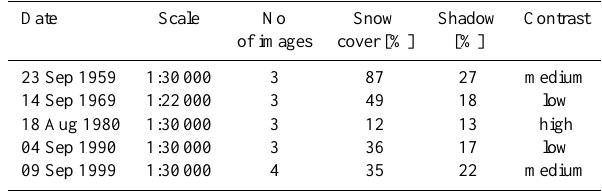
Table 1. Orthophoto information. The survey dates are based on information from Lantm¨ateriet and are also labelled on the image margins of the original photographs for 1980/90/99. The mean scale of the images is calculated from the average flight altitude. The frac- tion of areas influenced by snow and shadow is determined within a bounding box around Storglaci¨aren (cf. Fig. 2). The contrast at the glacier surface is qualitatively estimated from the